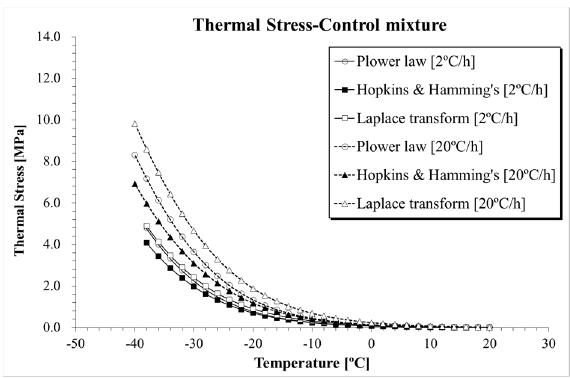
among the different computation solutions can be observed. In all cases, the highest, intermediate